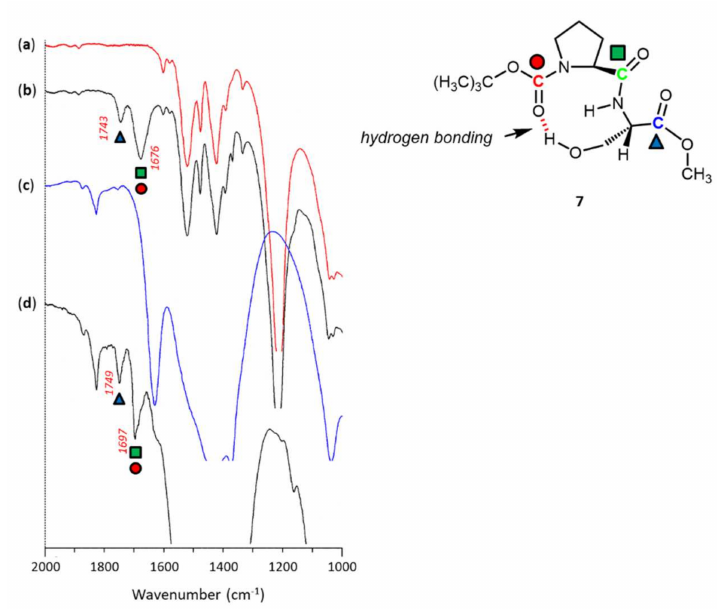
Figure 16. IR spectra of N -Boc-L-proline-L-serine-OMe 7 : ( a ) CHCl 3 (red line); ( b ) 20 mmol/L of 7 in